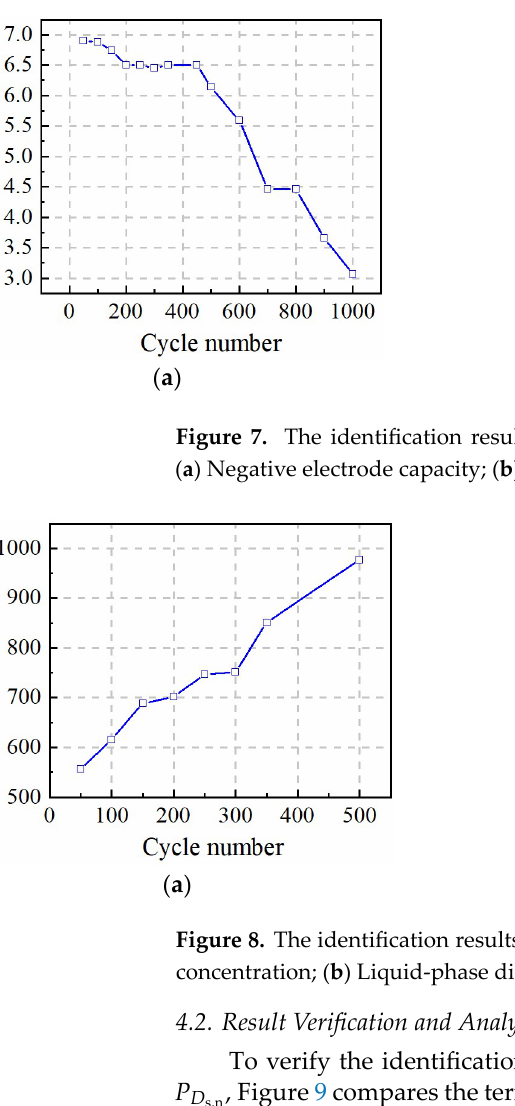
Figure 9. Validation of identification results of Q n and P D s,n .